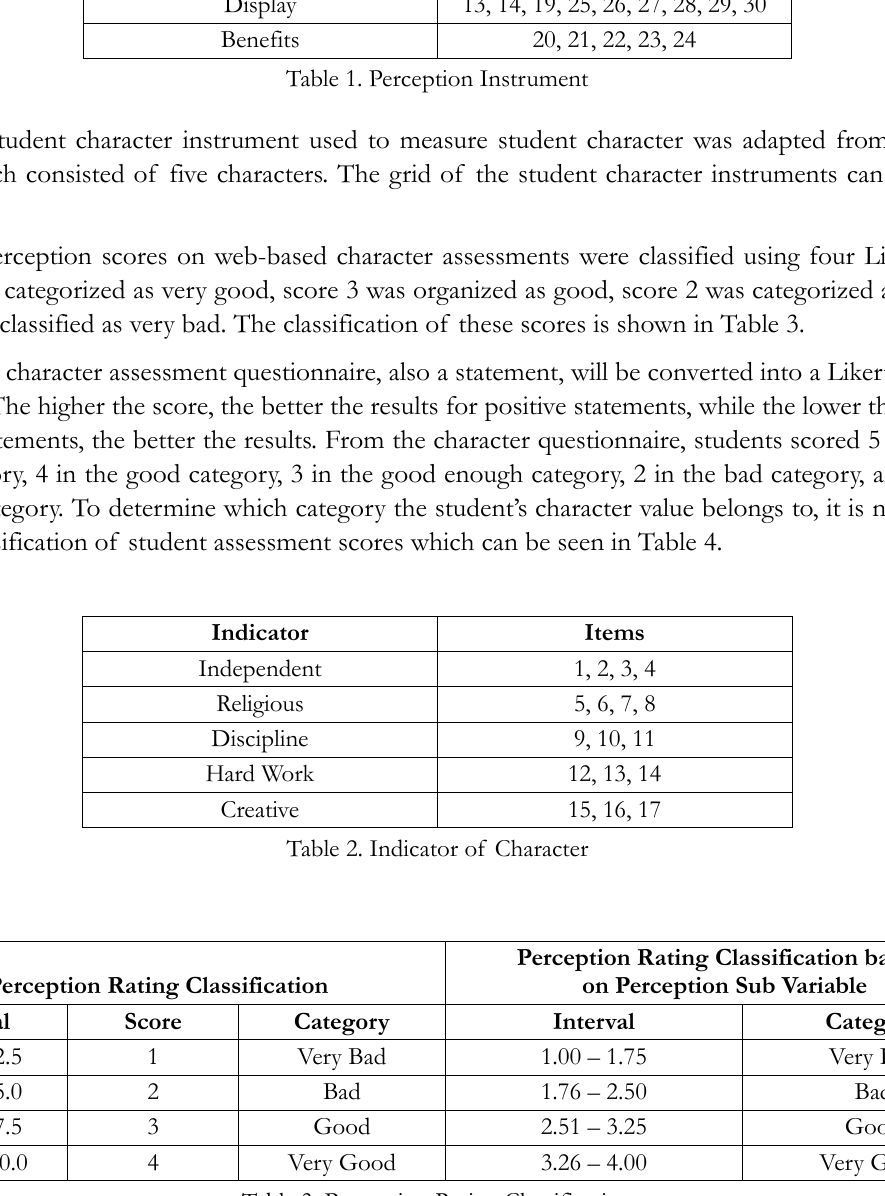
Table 3. Perception Rating Classification